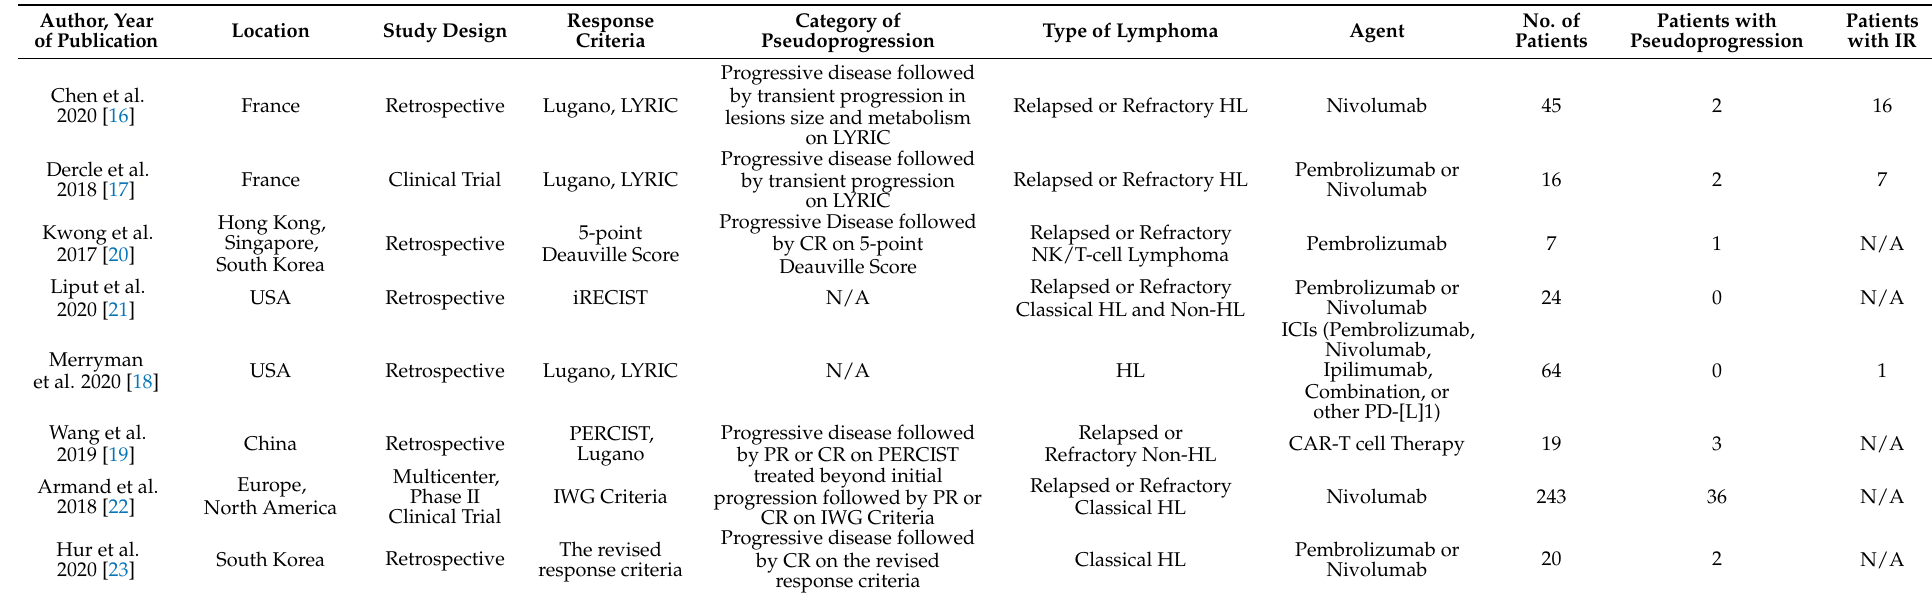
Table 1. Characteristics of Studies Included in the